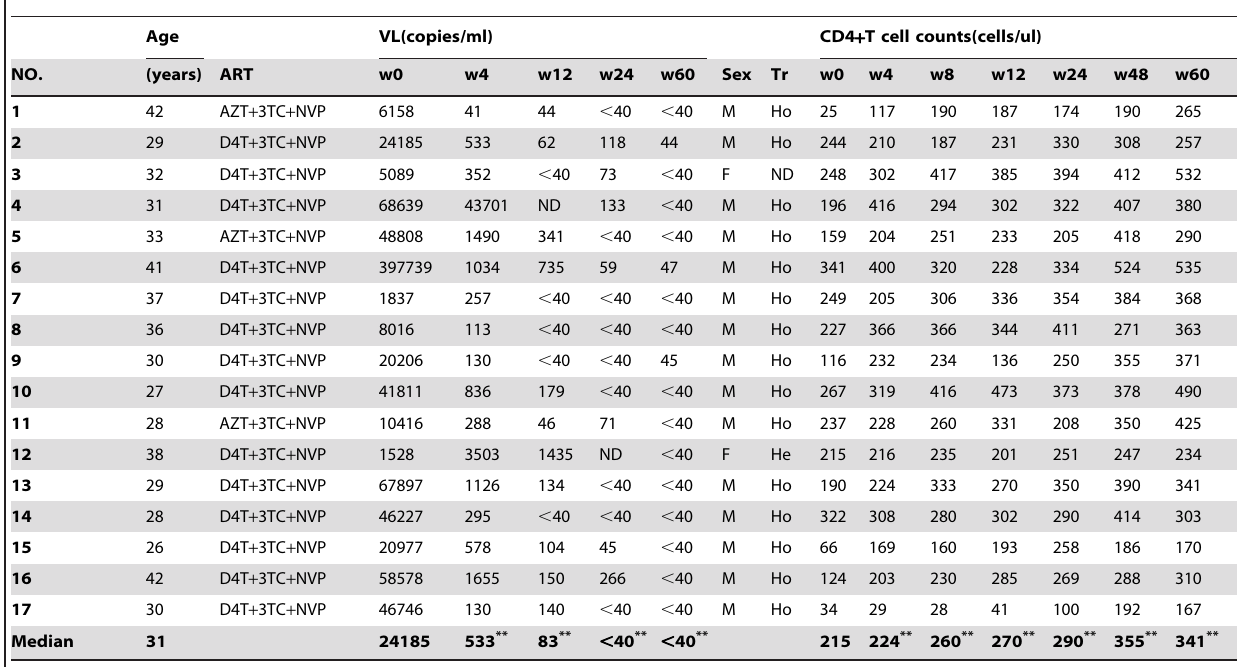
Table 1. Clinical characteristics of the 17 HIV-1-infected patients.